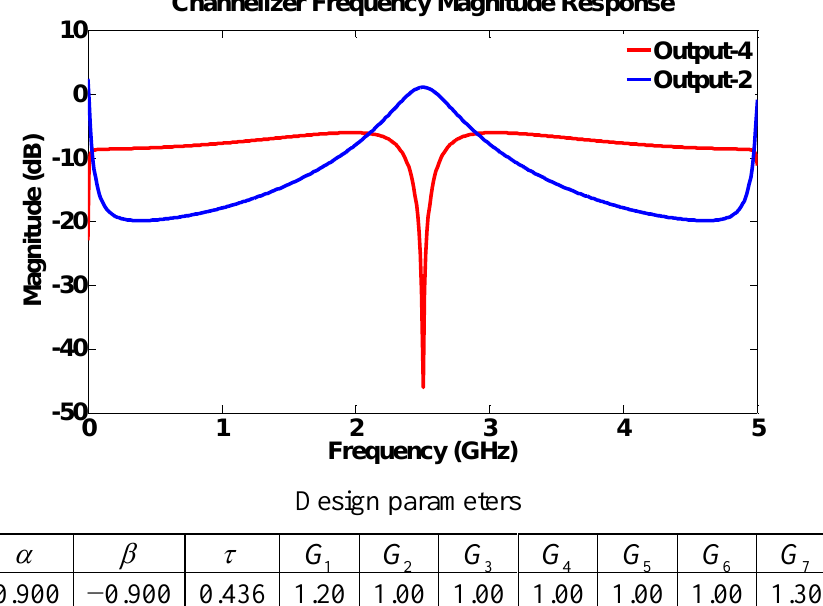
Figure 7. Frequency response for structure I using low transmission parameters.